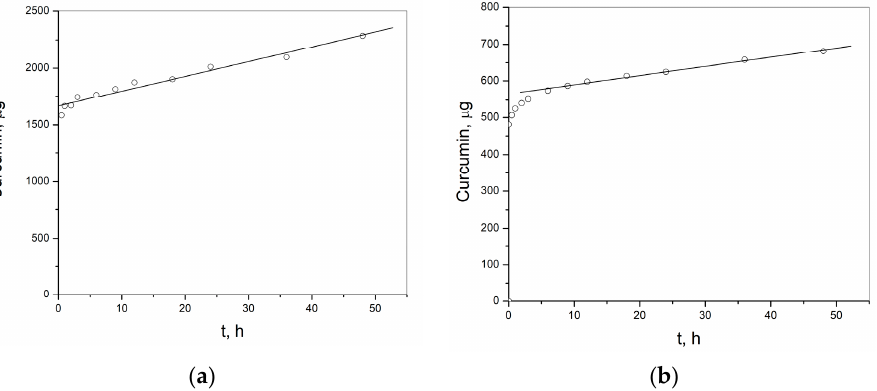
Figure 15. Profile of curcumin release from p(NiPMAm/NiPAm) hydrogels: ( a ) sample 10/90/2 and ( b ) sample 10/90/3. ( b ) sample